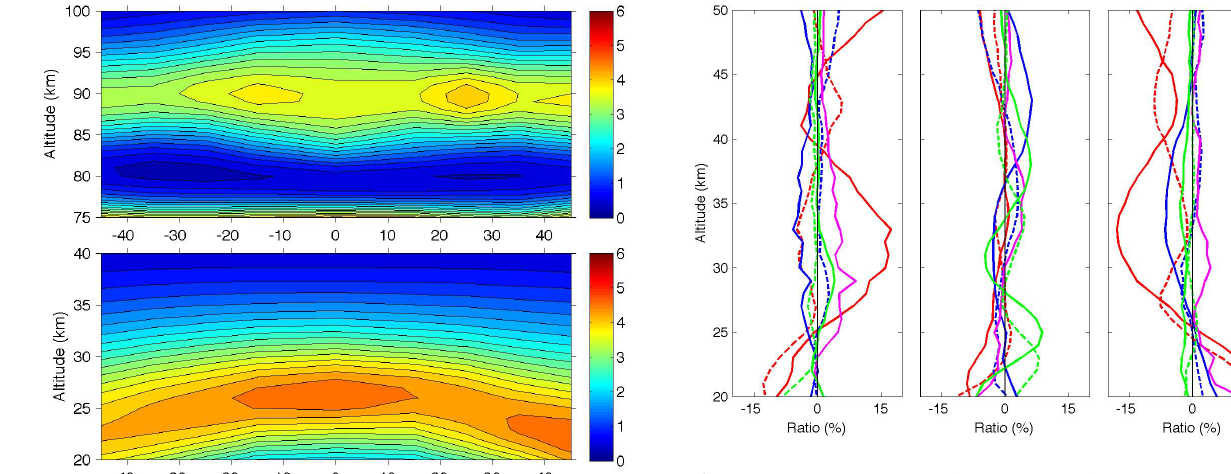
Fig. 12. Fitting components for ozone as a function of altitude in three latitude belts in the stratosphere. All amplitudes have been given as a ratio between the original amplitude in Eq. (2) and the the constant term c(z) in Eq. (2) and given in %. Line identifi- cations: annual ( a 1 and b 1 ): solid and dashed red, respectively, Semi-annual ( a 2 and b 2 ): solid and dashed blue, respectively, QBO 10hPa ( q 1 ) and 30hPa ( q 2 ): solid and dashed green, respectively, solar ( s ): solid magenta. The zero value line has been shown by a thin black line. Left: 50 ◦ S–40 ◦ S, Middle: 10 ◦ S–10 ◦ N, Right: 40 ◦ N–50 ◦